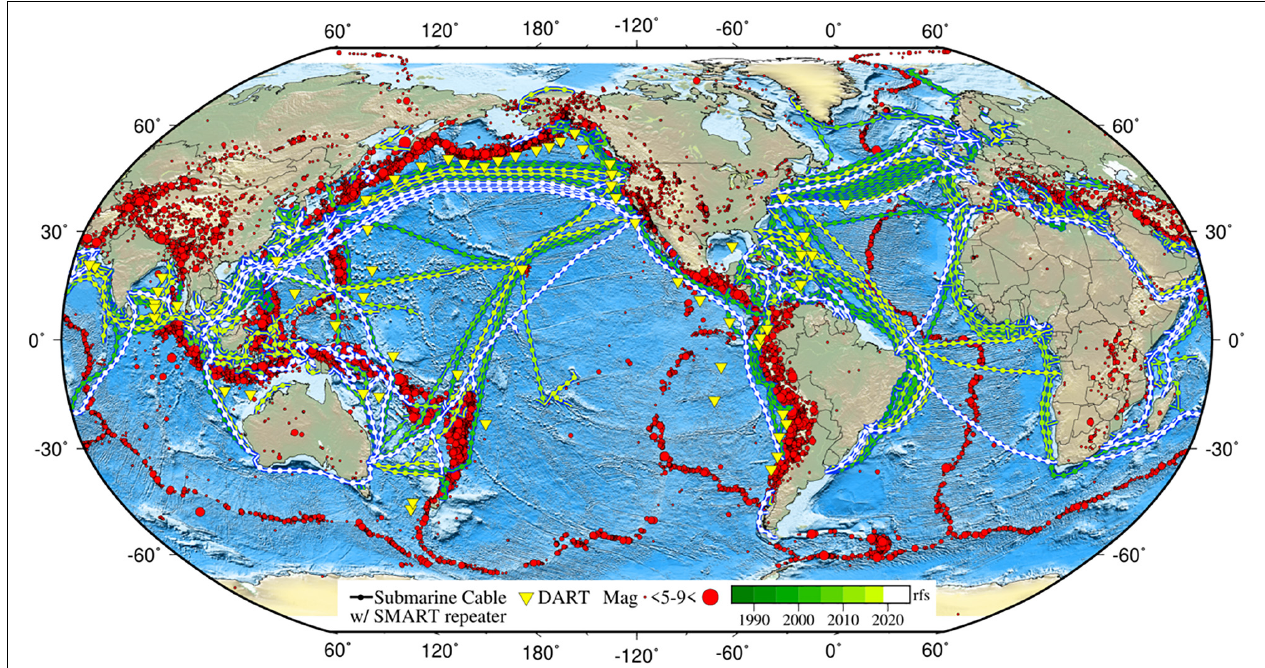
FIGURE 8 | Global map of ∼ 1 million km of operational submarine telecommunications cables (green present, white in progress/planned; SMART repeaters shown every 300 km; rfs – year ready for service), historical earthquakes (red), and DART tsunami buoys (yellow triangles). Cable data: TeleGeography’s Telecom Resources licensed under Creative Commons ShareAlike; DART Buoy locations: NOAA National Data Buoy Center; Seismic data: USGS Earthquake Catalog. Permission obtained for use of figure.